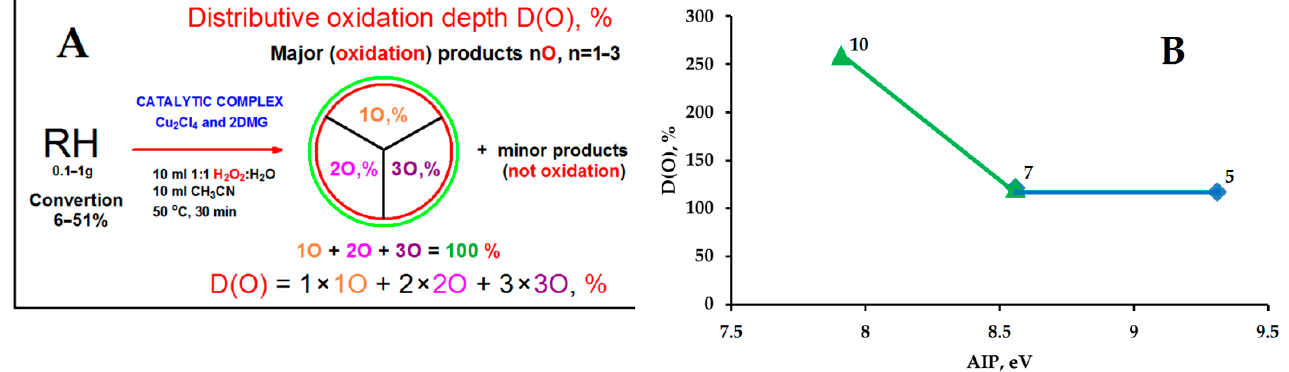
Figure 1. ( A ) The distributive oxidation depth D(O); ( B ) Three characteristic points (RH 5 , 7, and 10 ) on the dependence of D(O) on AIP–the first adiabatic ionization potentials of hydrocarbons RH. Equations of straight lines y = ax + b : blue: D(O) = 117 %; green: D(O) = − 221.55AIP + 2012 [43].